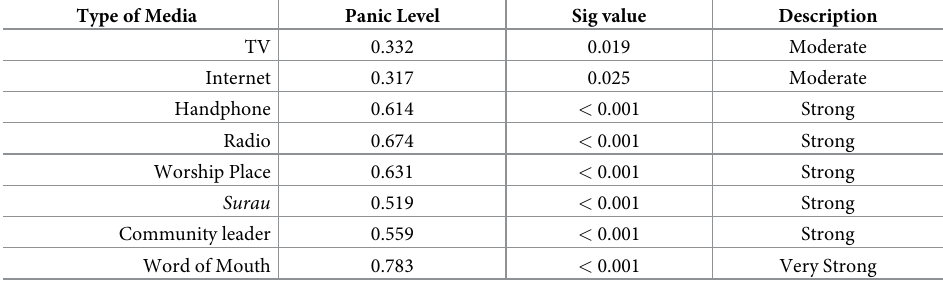
Table 7. The relationship between types of disaster information source media and panic level of affected commu- nity in Donggala Regency.